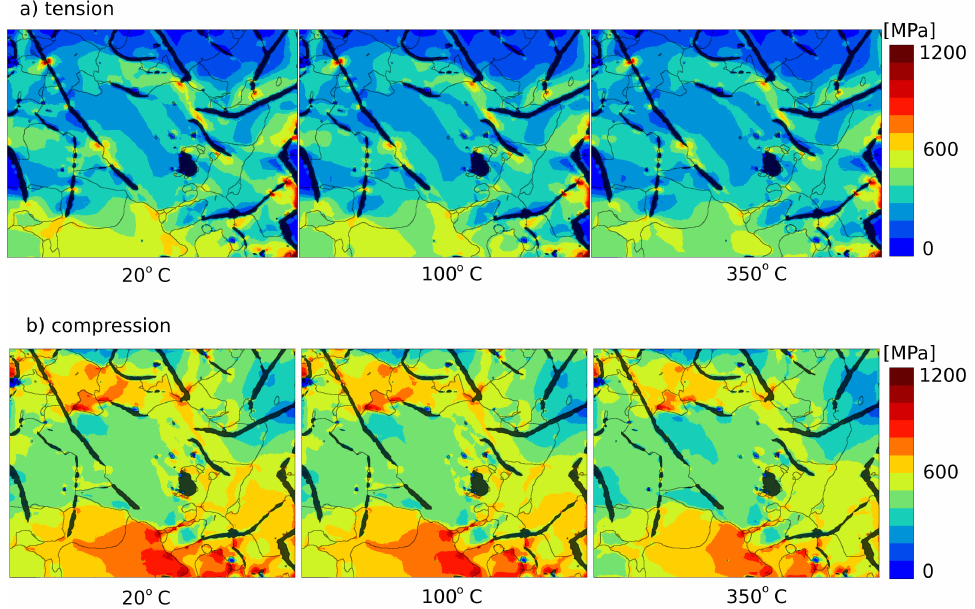
Figure 13. Von Mises stress distributions for different temperatures in tension ( a ) and compression ( b